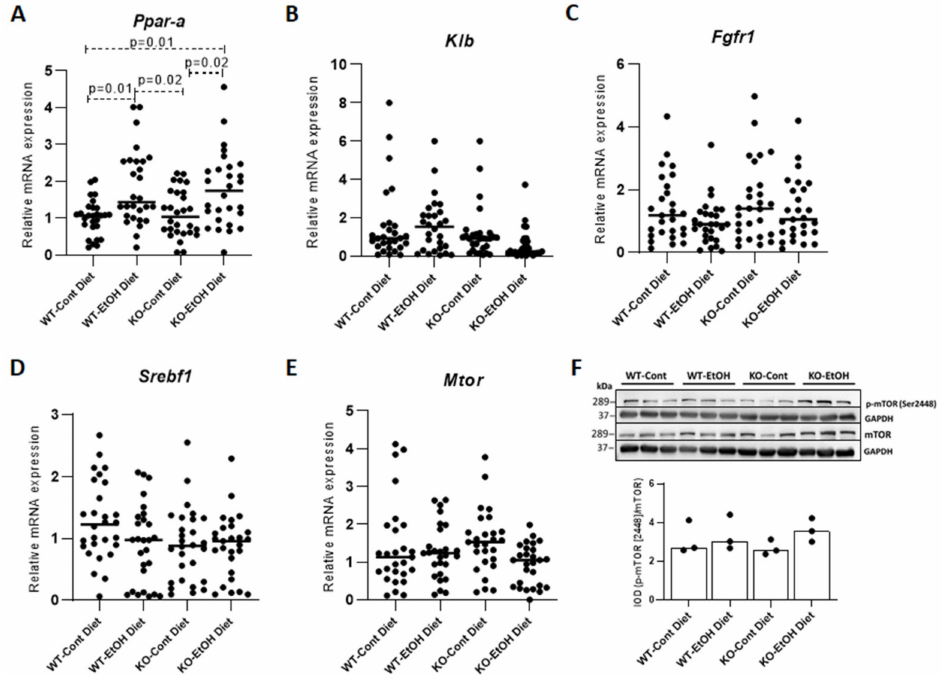
Figure 2. Relative quantification of hepatic mRNA levels. Transcriptional levels of Ppar-a ( A ), Klb ( B ), Fgfr1 ( C ), Srebf1 ( D ), and Mtor ( E ) were determined by qPCR in the liver ( n = 28 per group). Western blot analysis of hepatic p-mTOR (Ser2448) and total mTOR protein expressions ( n = 3 per group, each lane represents one mouse) and quantitative analysis of p-mTOR/mTOR by IOD normalized to GAPDH as a control ( F ). Cont, control diet; EtOH, ethanol diet; IOD, integrated optical density; KO, Abcb4 knockout mice; p, phospho; WT, C57BL/6J wild-type mice. p < 0.05 was considered